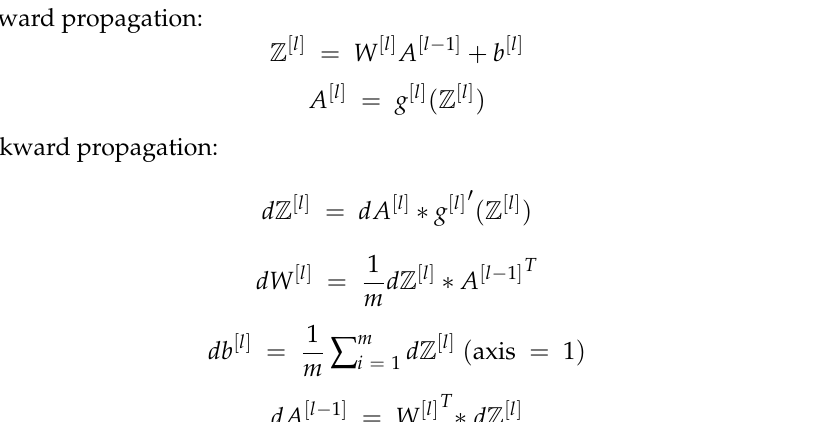
Figure 1. General structure of an Artificial Neural Network (ANN).